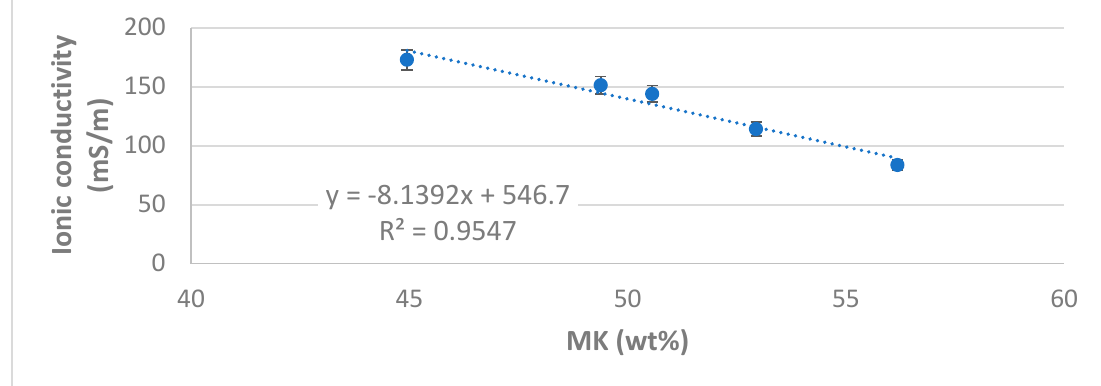
Figure 3. Ionic conductivity (IC) at 48 h of immersion vs. ( A ) immersion time of all geopolymers cured 28 days; ( B ) IC vs. the alkaline solution content; ( C ) IC vs. RC content; ( D ) IC vs. MK content. (Reproducibility of the test was calculated to be within an error of ± 5%).